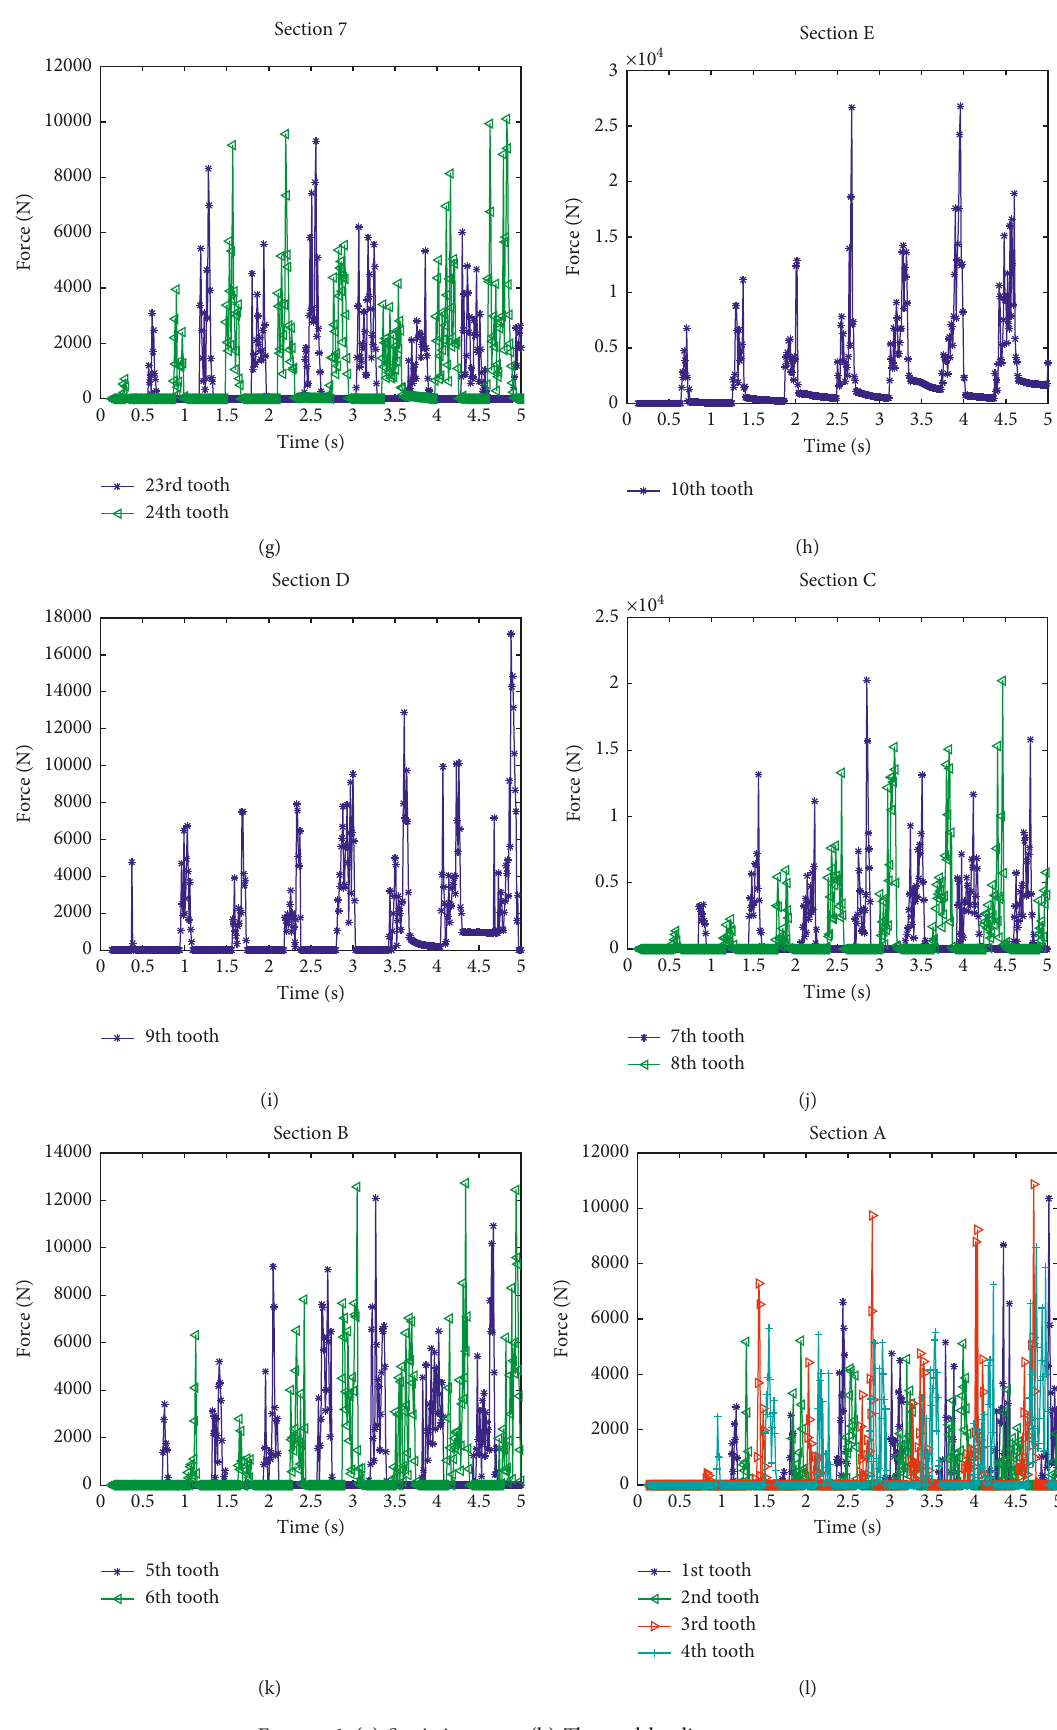
Figure 6: (a) Statistics zone. (b) The coal loading rate